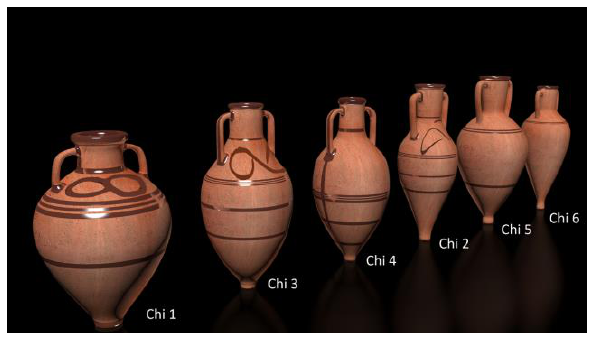
Figure 3. A group of Chian amphoras from 650-600 BC.